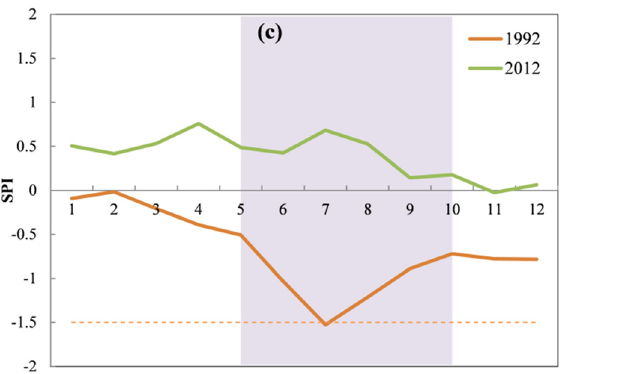
Figure 4. ( a ) Total area of pine caterpillars. Yellow lines indicate 1992–1997, 1998–2002, 2003–2007, and 2008–2012, respectively. ( b ) Distribution of pine caterpillar damage. ( c ) Inter-annual variation of SPI in 1992 and 2002. Dashed line represents the threshold of severe drought. Shaded region represents the growing season.